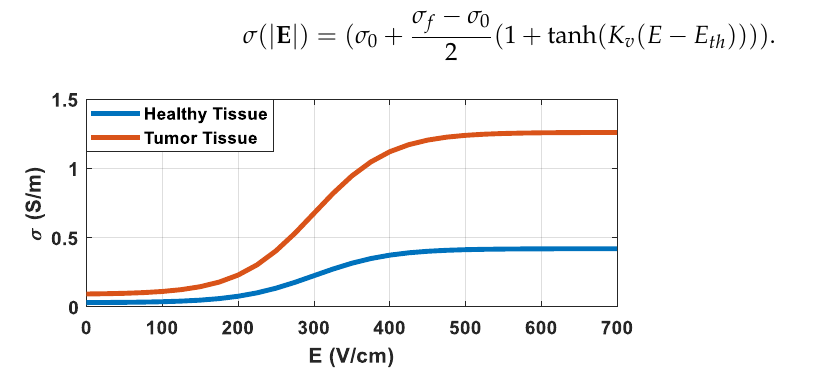
Figure 6. Electrical conductivity of the simulated tissue, as a function of the electric field applied at 10 kHz [21,27].